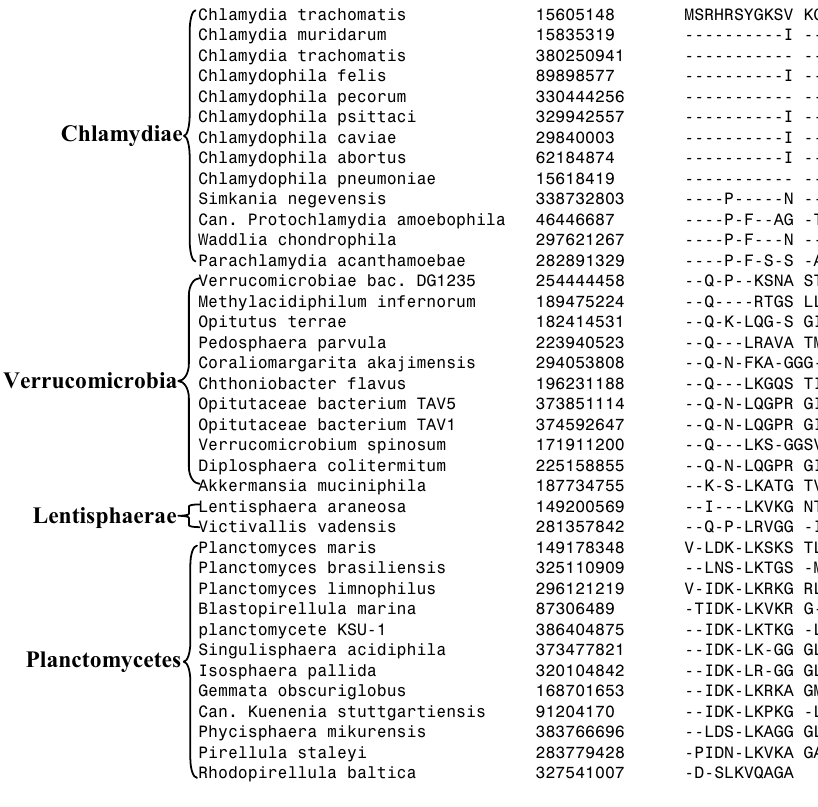
FIGURE 6 | Sequence alignment of a protein of unknown function that is uniquely found in various species from the PVC phylum of bacteria